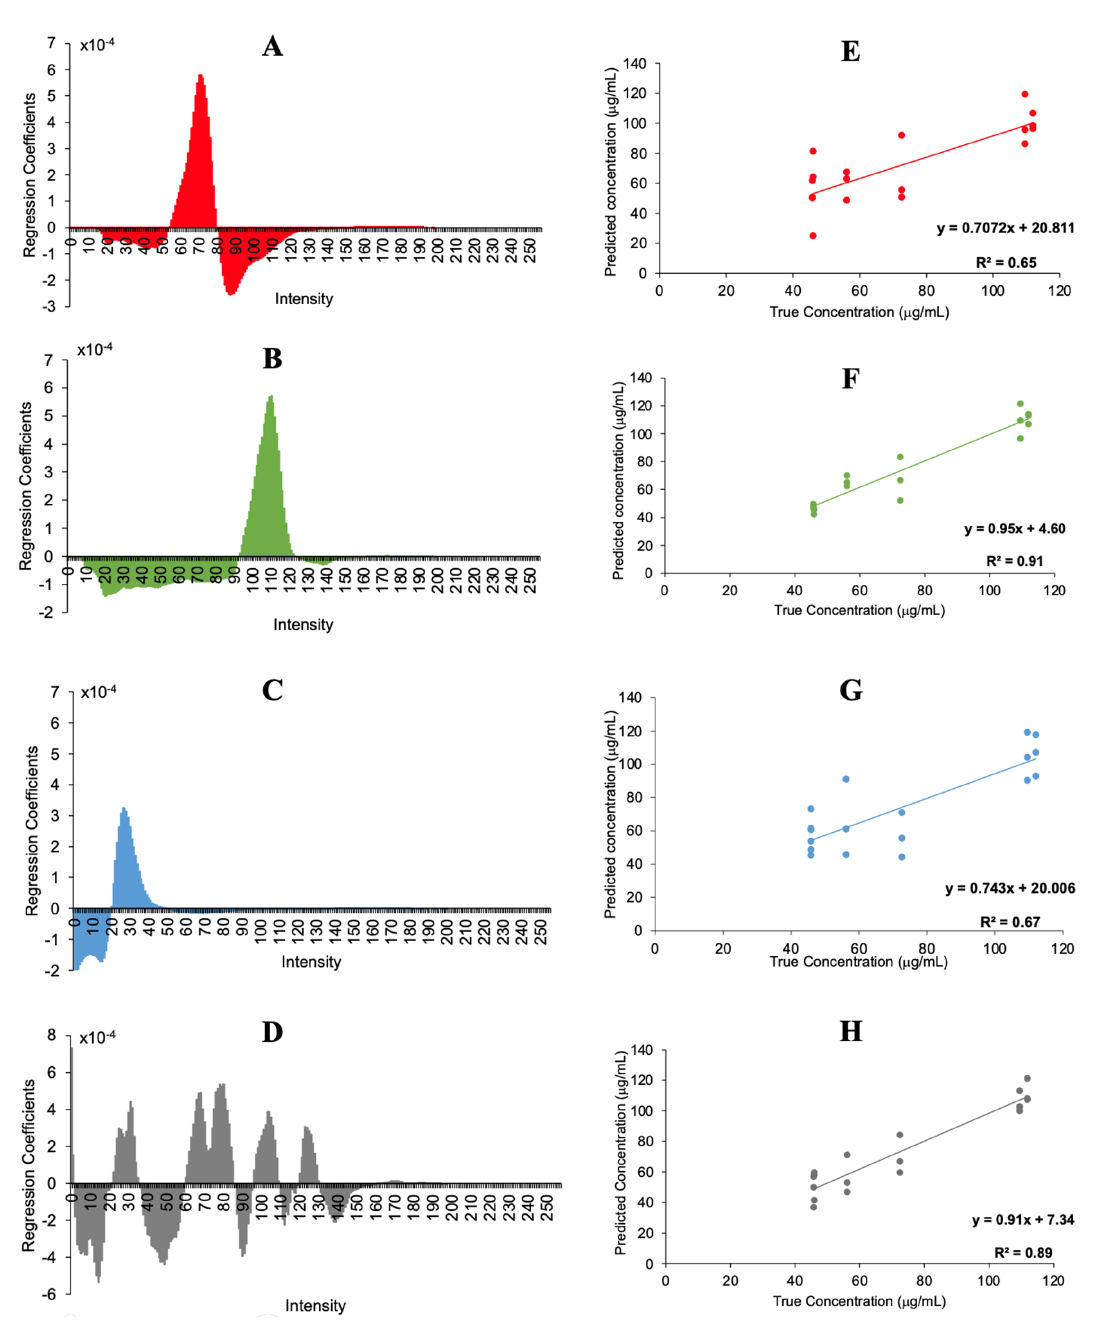
Figure 4. PLS regression coefficients plots ( A – D ) and predicted versus actual concentration ( E – H ) of the R, G, B and RGB histogram channels.